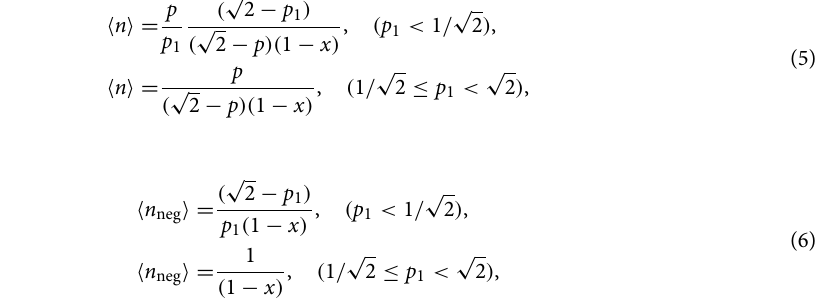
0 . For p 1 < p in (c), (cid:31) n neg (cid:30) converges to a constant value = √ 2 , n ∗ n neg p decreases sharply to one. neg � . Near � (cid:31) (cid:30) =